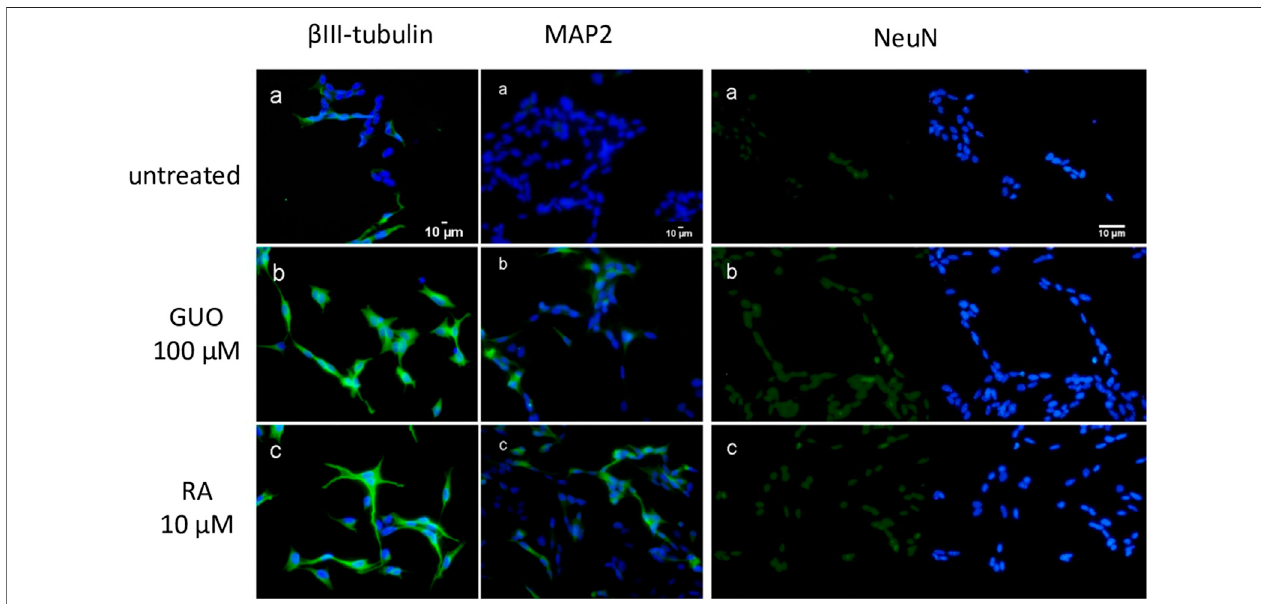
FIGURE 2 | Guanosine increases the expression of speci fi c mature neuronal markers in SH-SY5Y neuroblastoma cells. SH-SY5Y cells were cultured for 48 h withouttreatment (a) orinthepresenceof100 µMGUO (b) or10 µMRA (c) . β III-TubulinandMAP2 fi lamentsarehighlightedingreenwhilenucleiarestainedinbluewith DAPI. For NeuN expression, on the left side of the image nuclei are stained in green with NeuN while on the right side of the image nuclei are stained in blue with DAPI. Images are representative of one of three independent experiments.